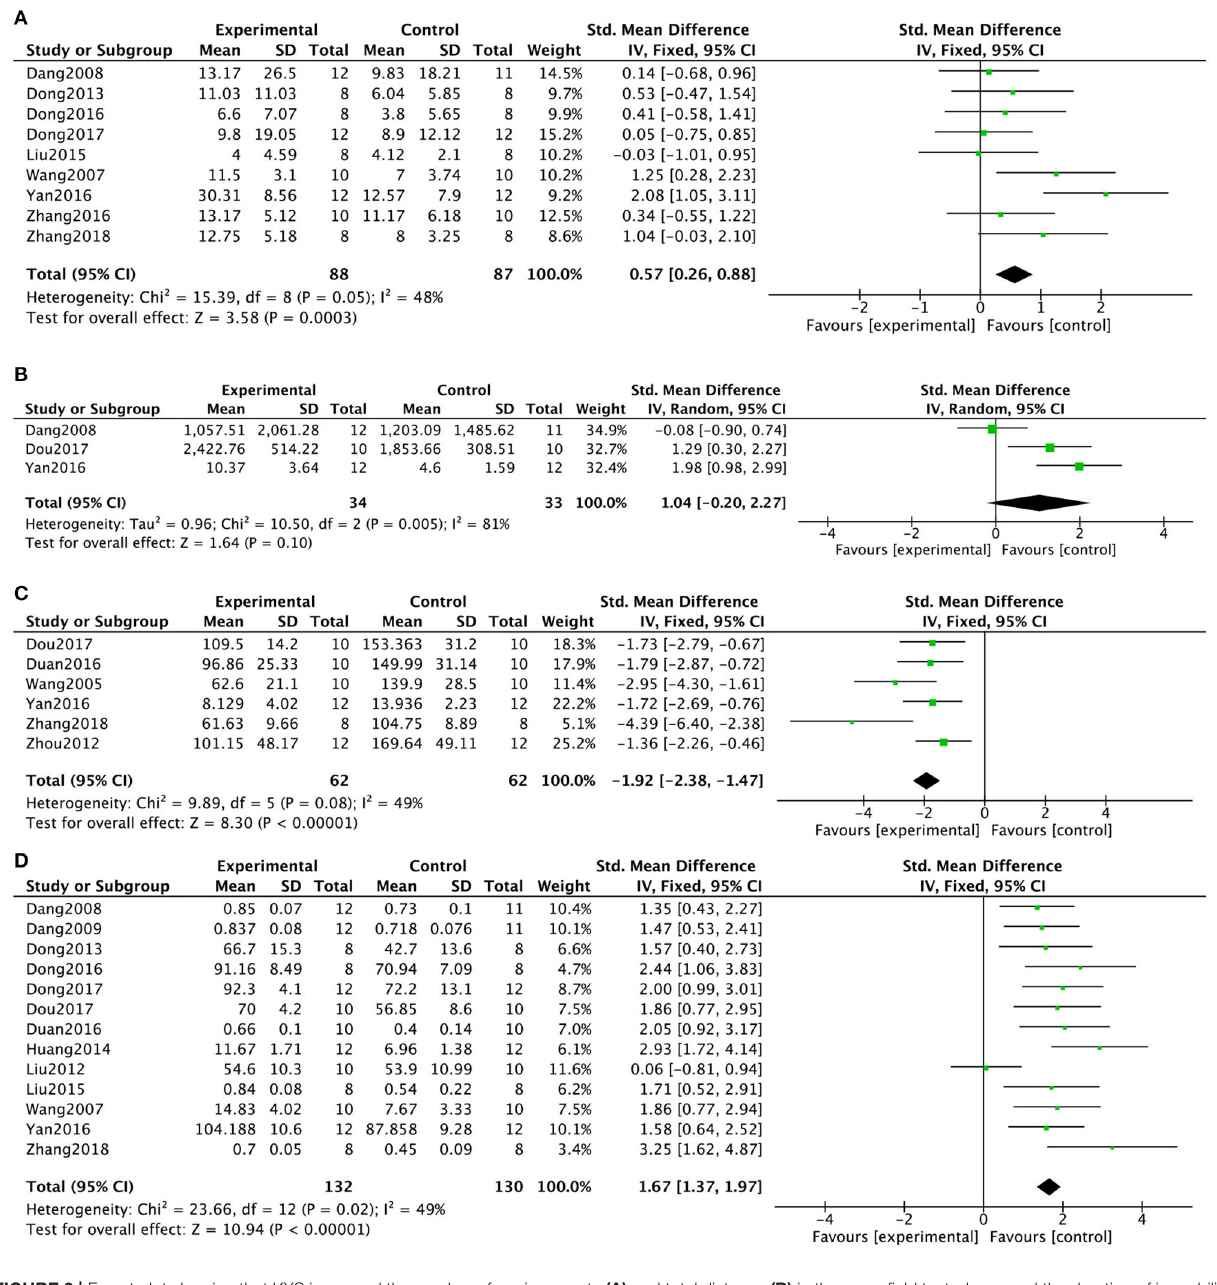
FIGURE 3 | Forest plot showing that KXS increased the number of rearing events (A) and total distance (B) in the open-field test, decreased the duration of immobility in the forced swimming test (C) , and increased sucrose consumption in the sucrose preference test (D) compared with the Control